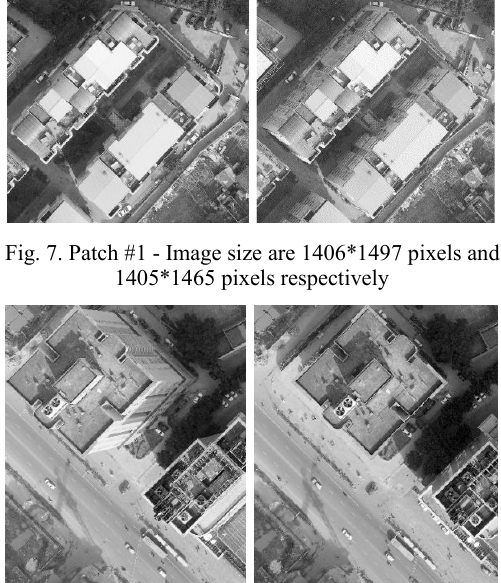
Fig. 8. Patch #2 - Image size are 2296*1971 pixels and